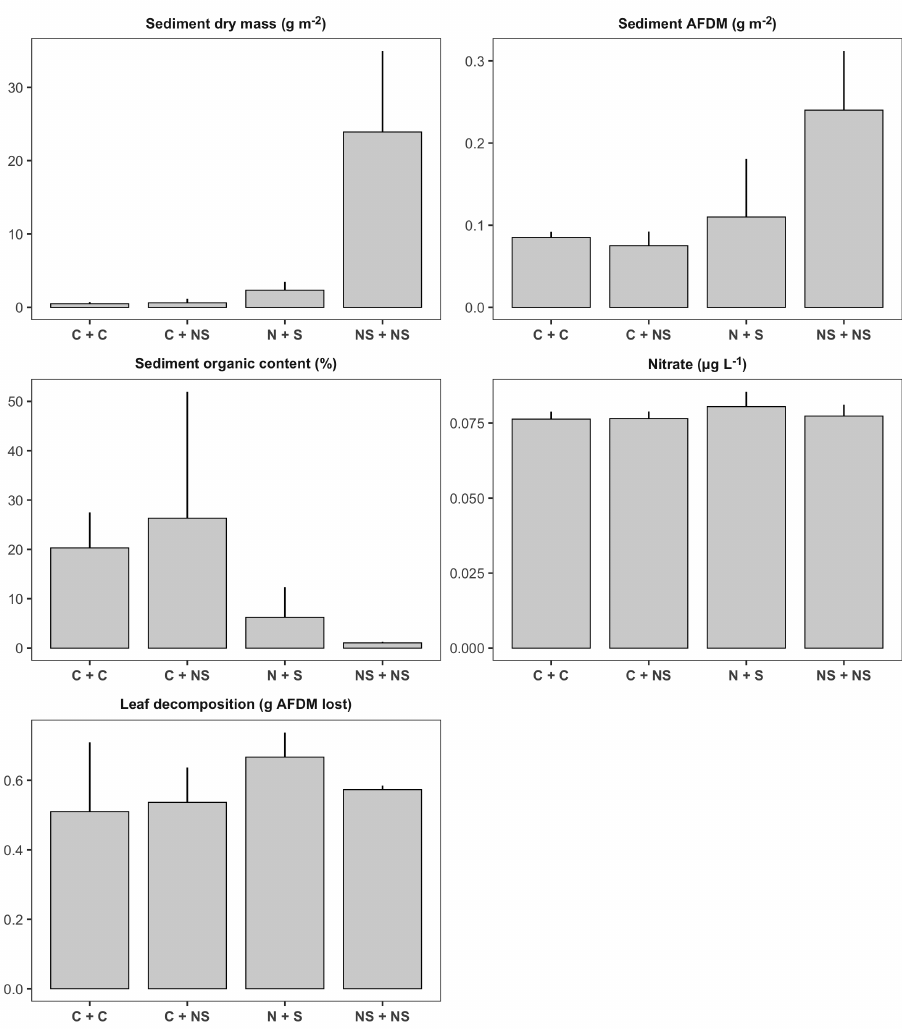
SD) of habitat and ecosystem function variables in second-order channels: Figure 6. Bar plots illustrating treatment means ( ± two control tributaries (C + C, n = 3), one control tributary and one tributary with both stressors (C + NS, n = 3), nutrients added in one tributary and sediment in the other (N + S, n = 3), nutrients and sediment added in both tributaries (NS + NS, n = 3). Y-axis units for each panel are indicated in the panel’s